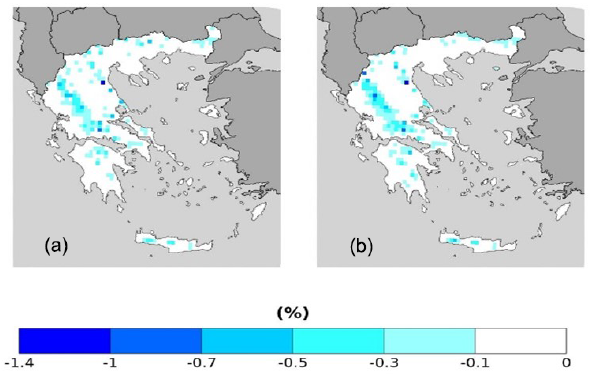
Figure 13. RR20ID copula method probability differences